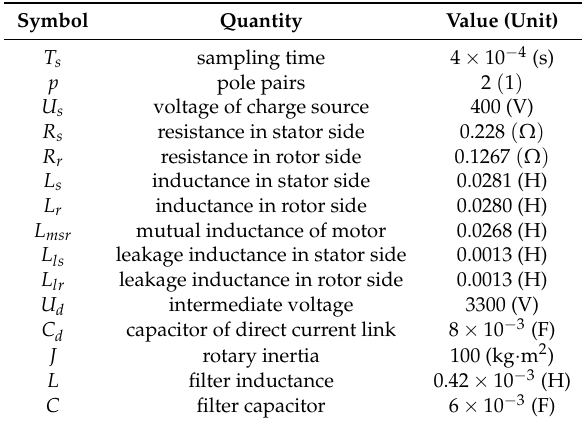
Table 1. The parameters for the